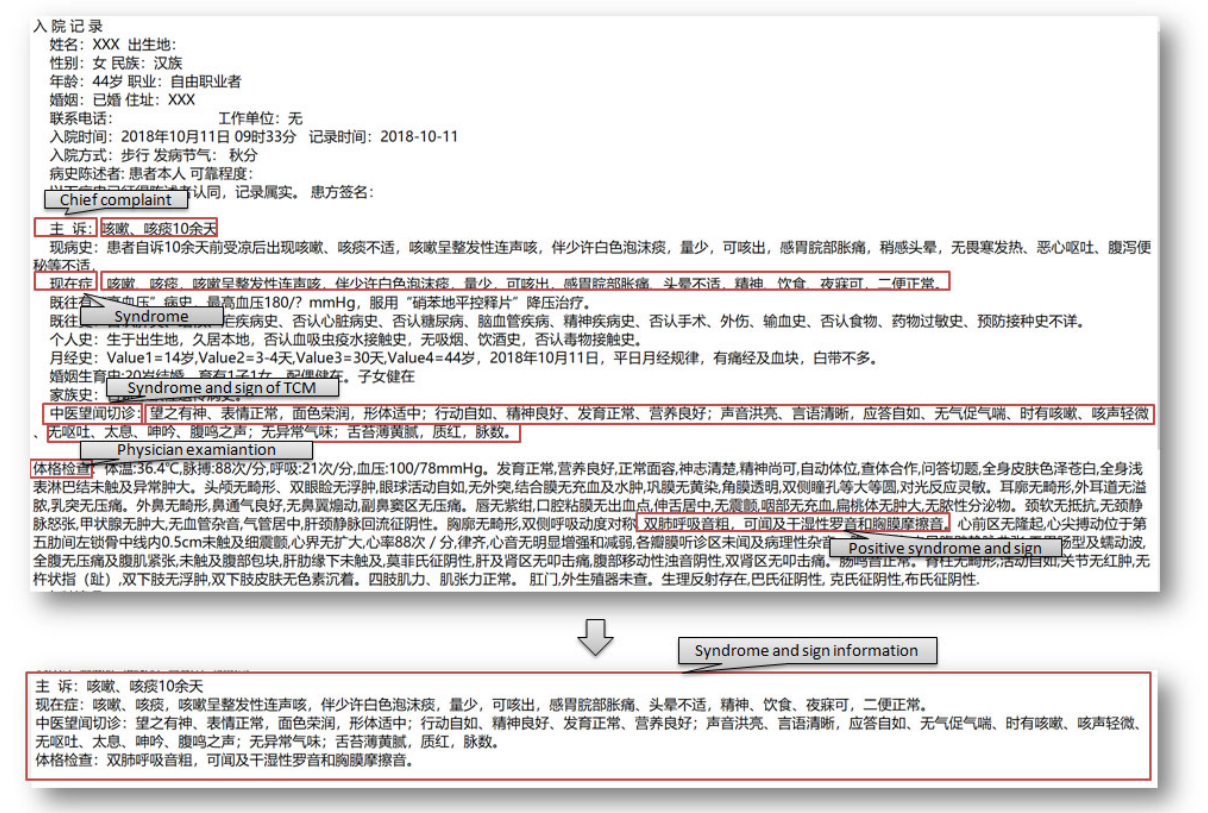
Figure 2. The Chinese text information on the chief complaints, syndromes, and positive signs in the chest, tongue, and pulse that was extracted